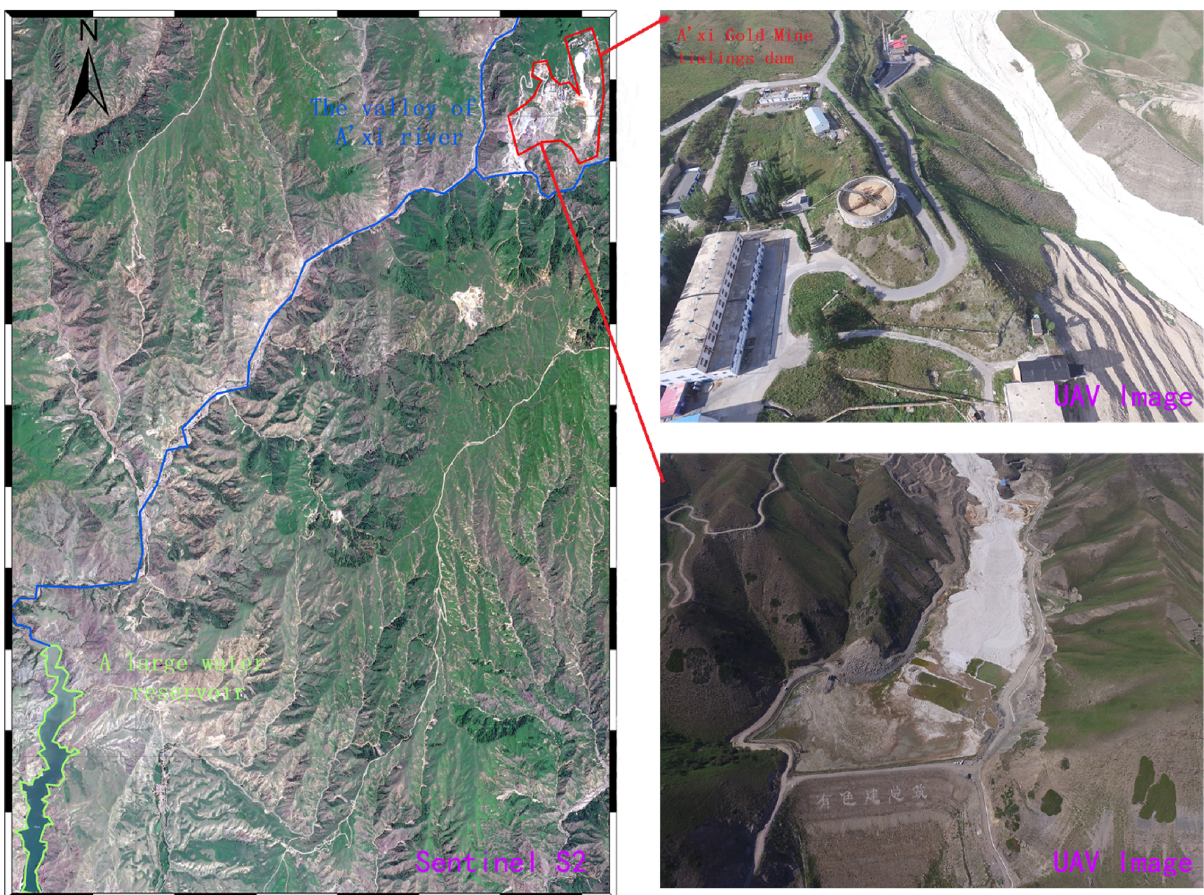
Figure 7. Location of A’xi gold mine tailing dam: the red area is the A’xi gold mine complex; the blue line represents the valley of the A’xi River; the green area represents a large water reservoir. Image data: Sentinel Satellite S2 imagery and UAV imagery.